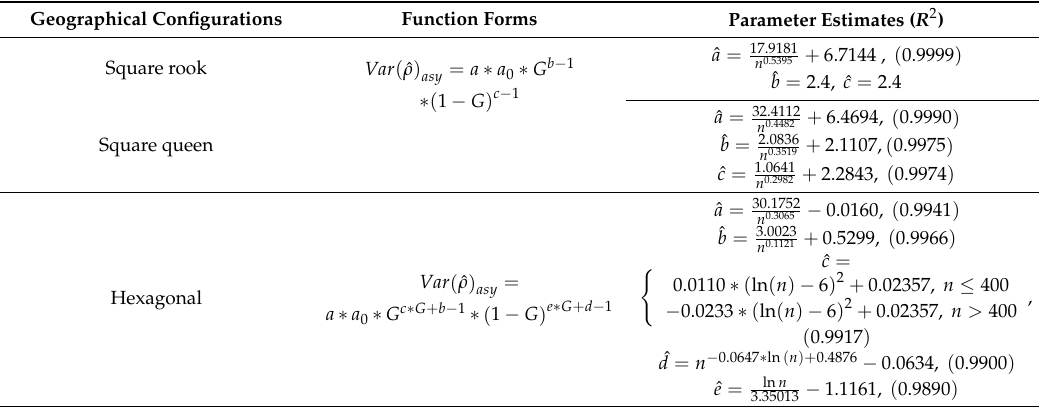
Table 3. Theoretical functions for asymptotic variance versus ˆ ρ .